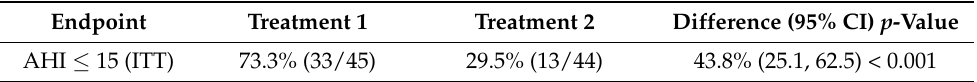
Table 2. Primary Endpoint 1: ITT comparison of proportions with AHI ≤ 15 by randomization group at visit 2.